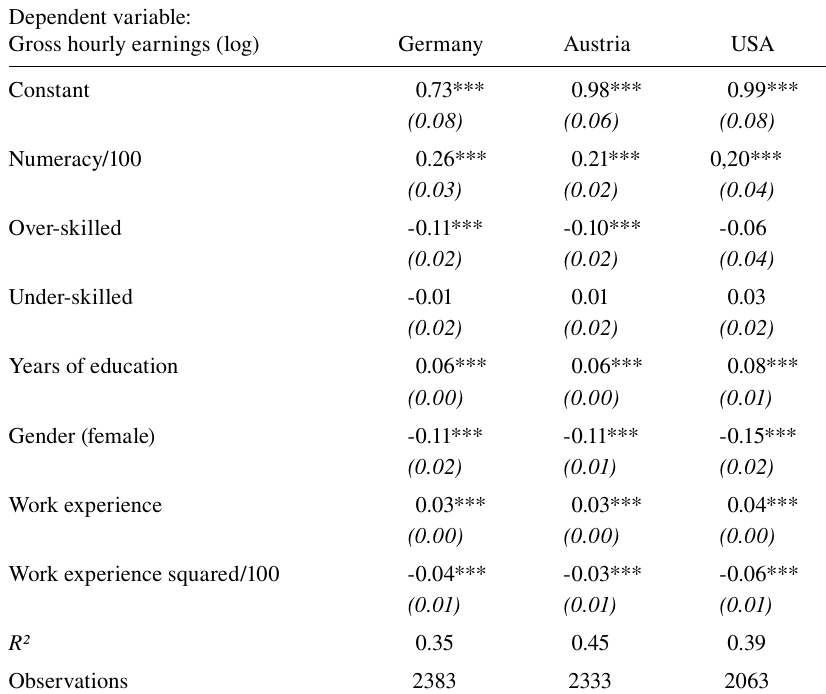
Table A.2 Mincer regressions with skill-mismatch according to Quintini